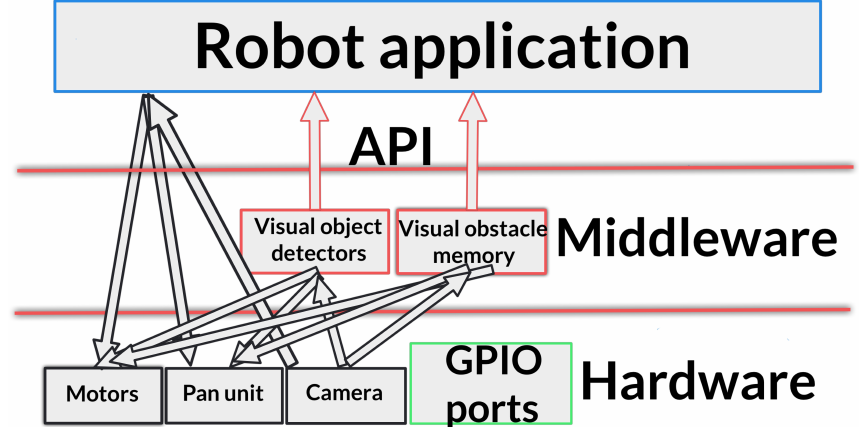
Figure 5. Visual system block